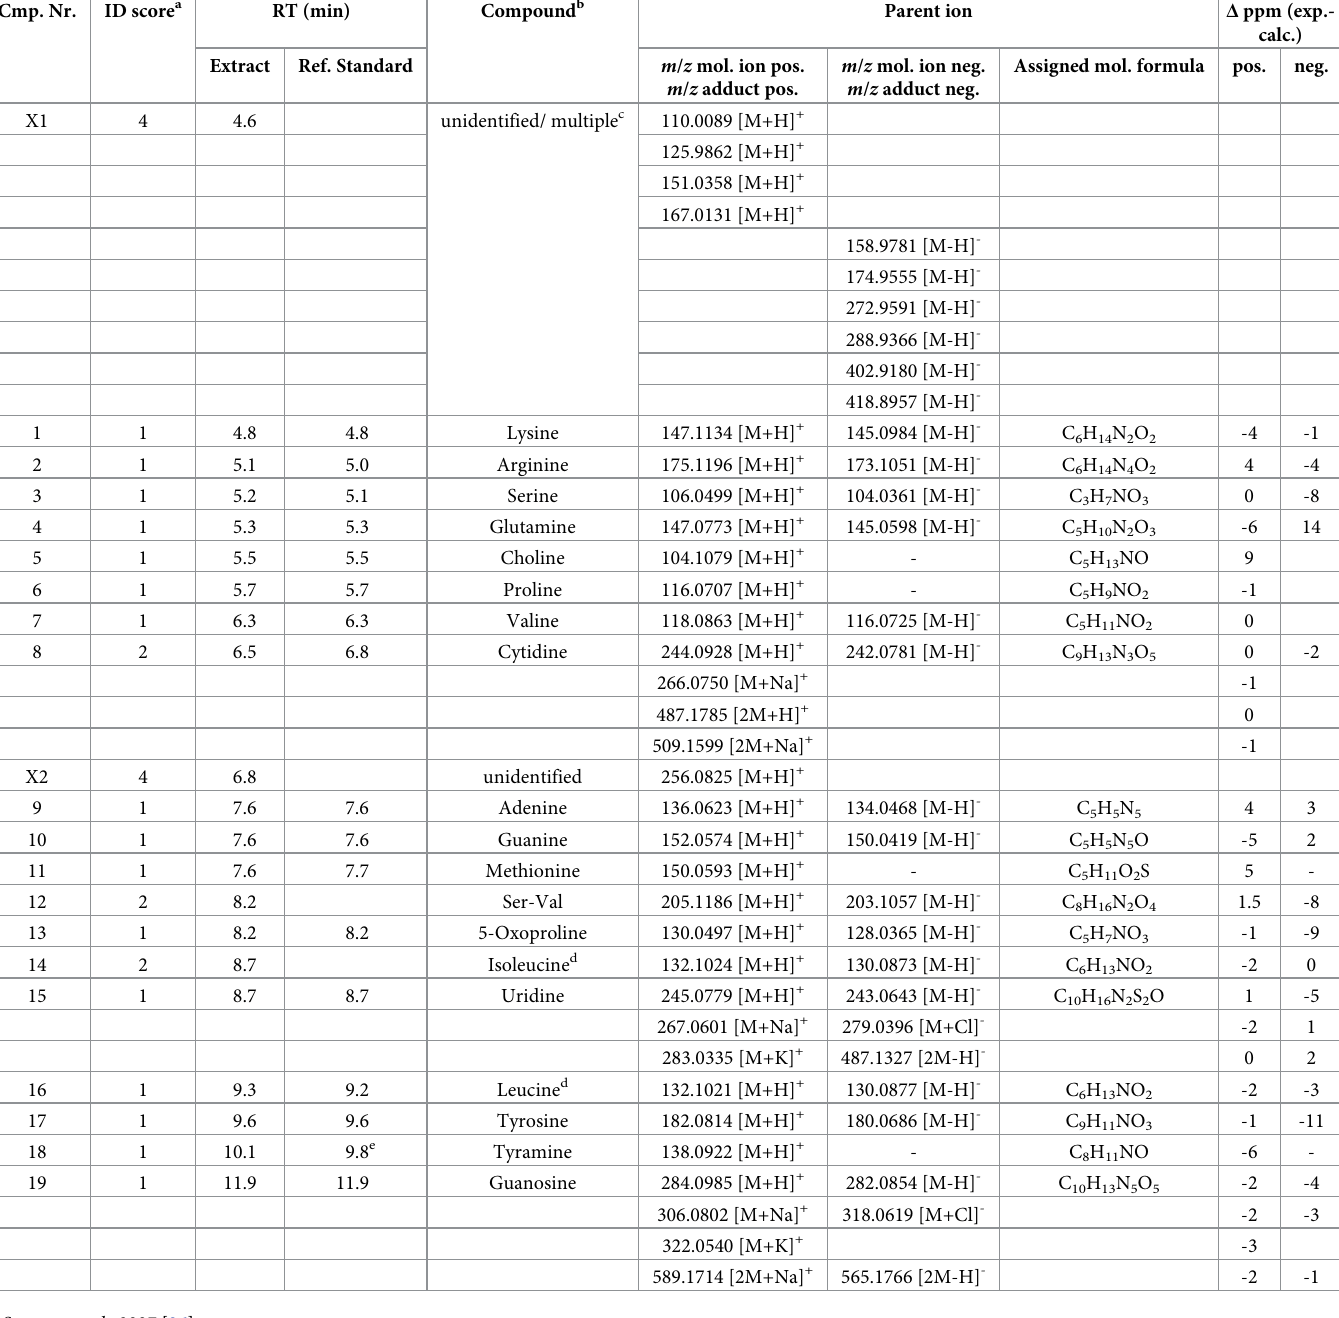
Table 2. LC-MS/MS data of compounds contained in the anti-listerial fraction isolated from Eruca sativa . Cmp.